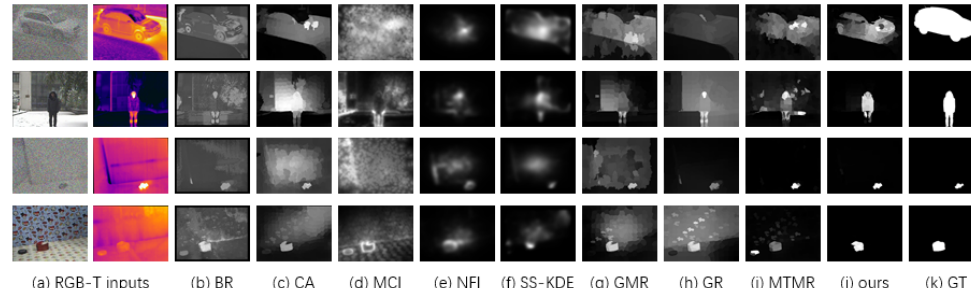
Figure 4. Sample results of the proposed approach and other baseline methods with the fusion of RGB and thermal inputs. ( a ) The first two columns are the origin RGB images and thermal images.